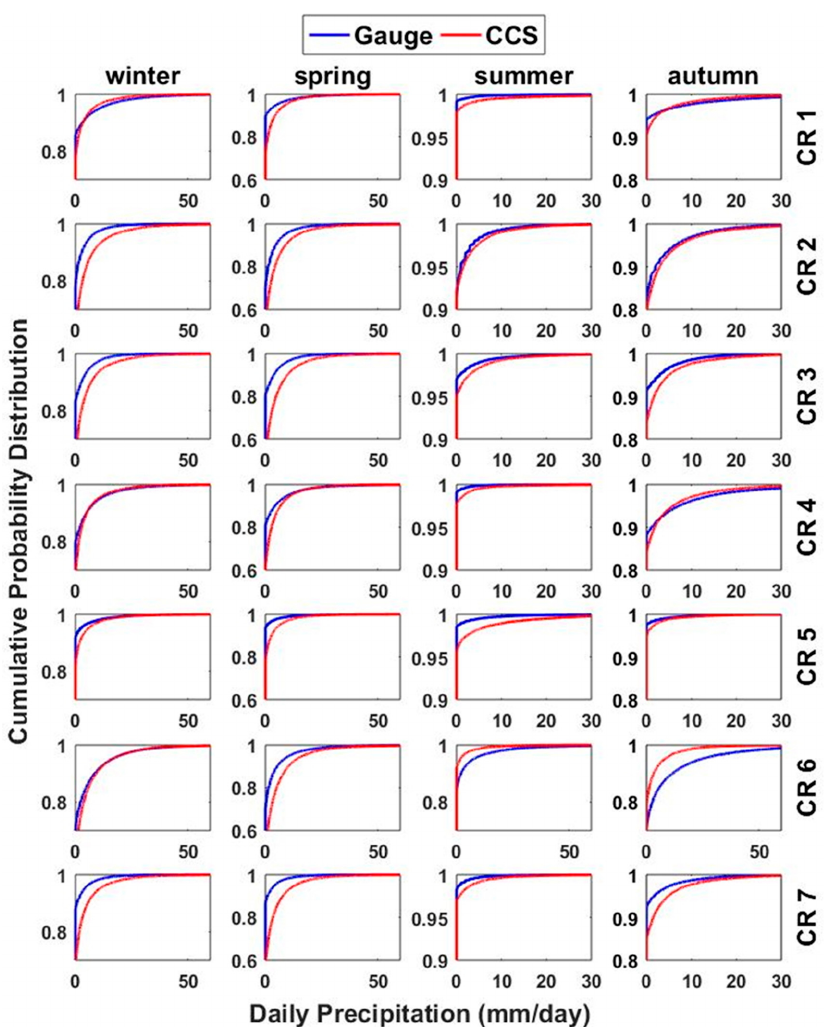
Figure 2. The seasonal cumulative distribution function (CDF) of the daily precipitation for the gauge and Precipitation Estimation from Remotely Sensed Information using Artificial Neural Networks-Cloud Classification System (PERSIANN-CCS) (CCS) estimations for the seven climate regions (CRs) for the calibration period.